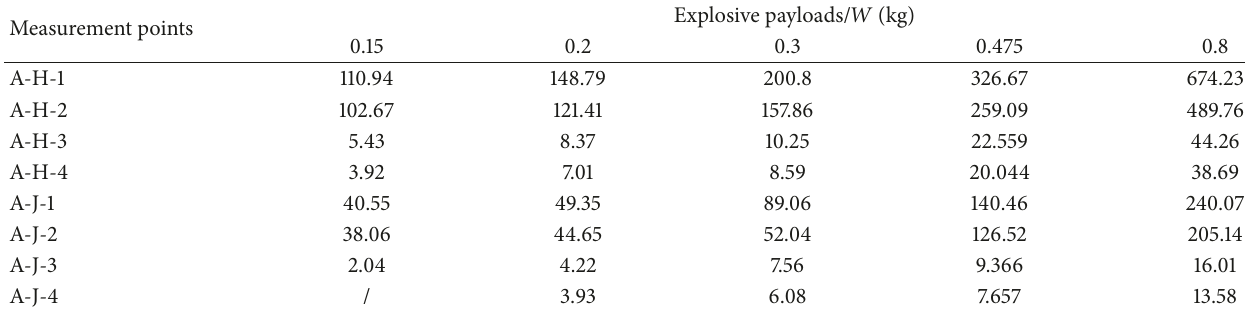
Table 8: The strain peak of Model 2 at different measurement points ( × 10 −6